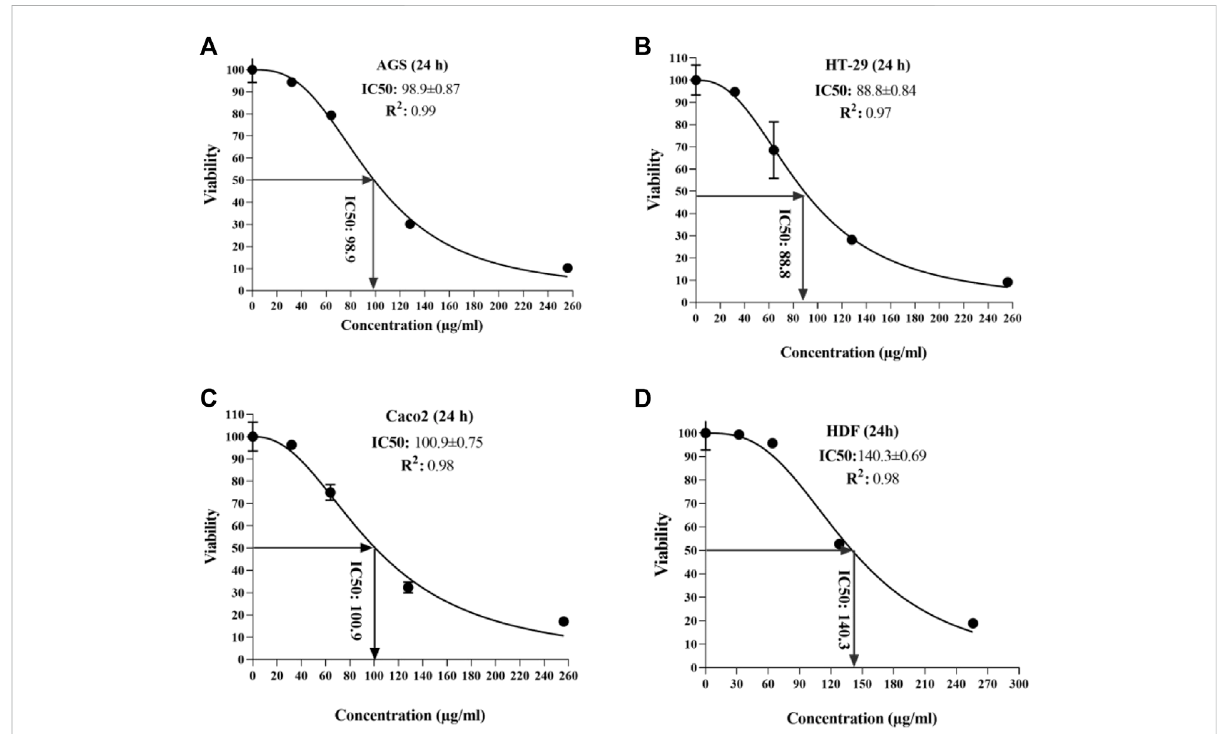
FIGURE 3 Half-maximalinhibitoryconcentrationof T.canis ESTPPincelllinesafter24h;thehighestvaluewasobservedinnormalcells(140.3) (D) andthe lowest in HT-29 cells (88.8) (B)